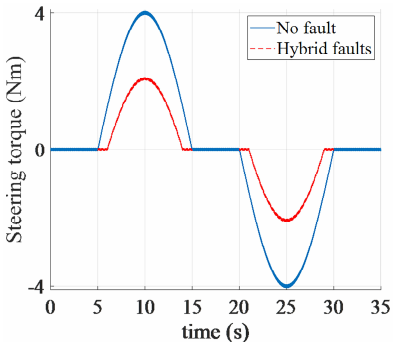
Figure 5. Hybrid faults with constant deviation and gain variation.